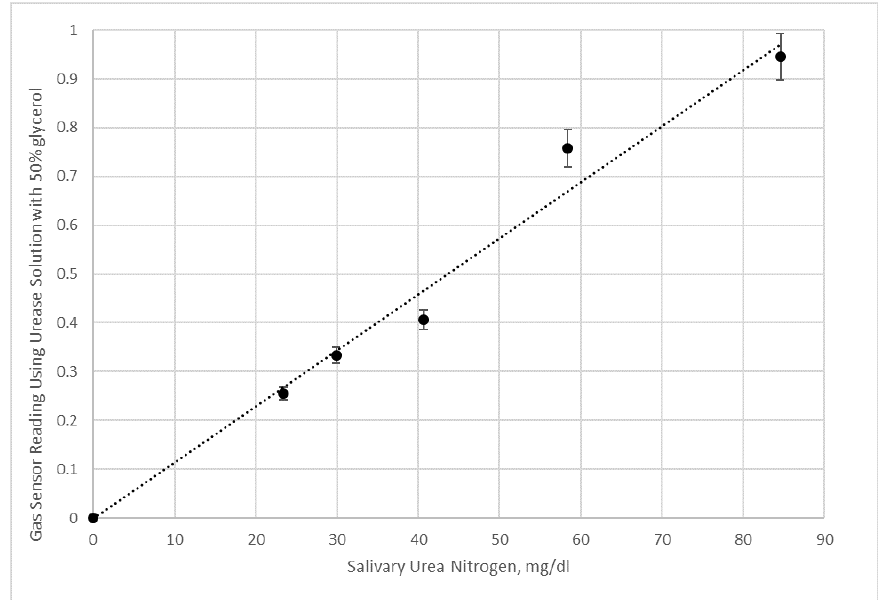
Figure 11. Here electronic nose measurements of saliva samples and saliva samples with added urea given in terms of salivary urea nitrogen were done in duplication. Data shown are using a 50% glycerol urease solution.